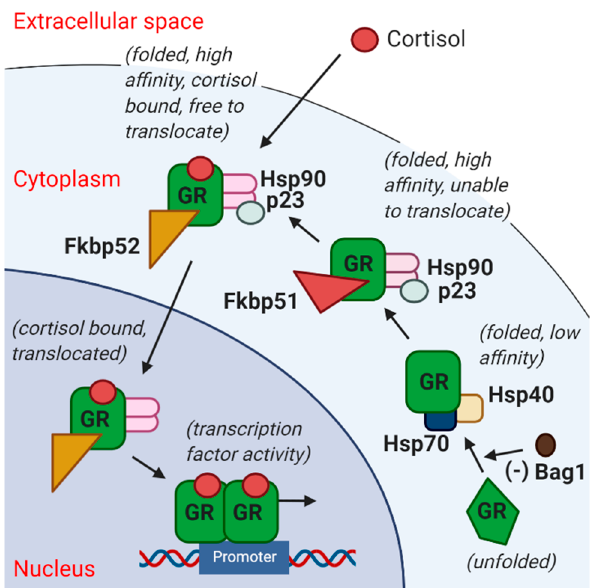
Figure 1. Simplified diagram of the glucocorticoid receptor (GR) stress signalling pathway. GR (unfolded) is unable to bind cortisol when bound to Bag1, and release of Bag1 allows GR to bind cortisol with low affinity, whereas Fkbp51 (encoded by Fkbp5 ) and p23 (encoded by Ptges3 ) are involved in increasing GR affinity to cortisol by stabilizing the GR heterocomplex into a high affinity state. Furthermore, Fkbp52 (encoded by Fkbp4 ) dislocates Fkbp51 and facilitates nuclear translocation of the cortisol-bound GR heterocomplex into the nucleus to activate or repress target genes. Thus, higher Fkbp51 would promote GR retention in the cytoplasm, rendering target genes less responsive to stress [16–19] . GR = glucocorticoid receptor; Hsp = heat shock protein.